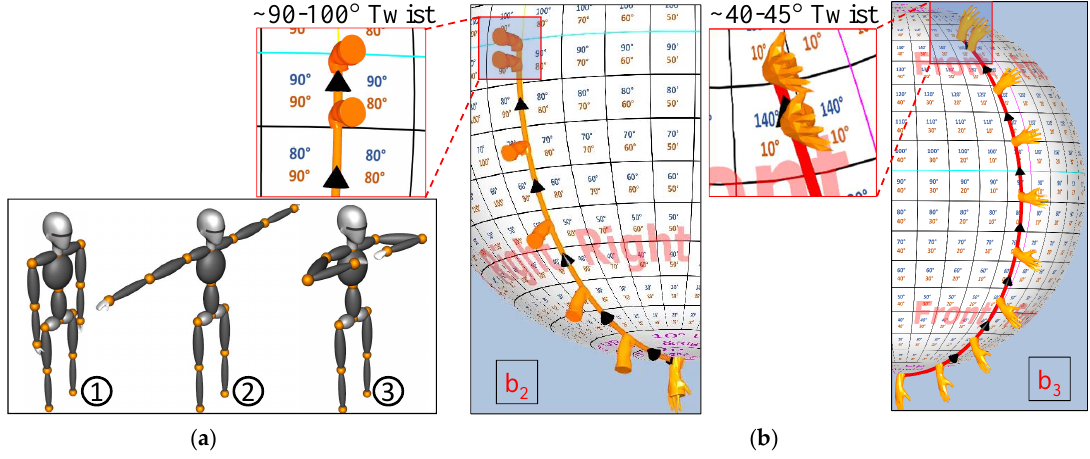
Figure 9. ( a ) Reconstruction of the ROM movement of the lower arms on a 3D avatar ( b ) Visualization of the right arm ( b 2 , b 3 ) on a Motion-sphere